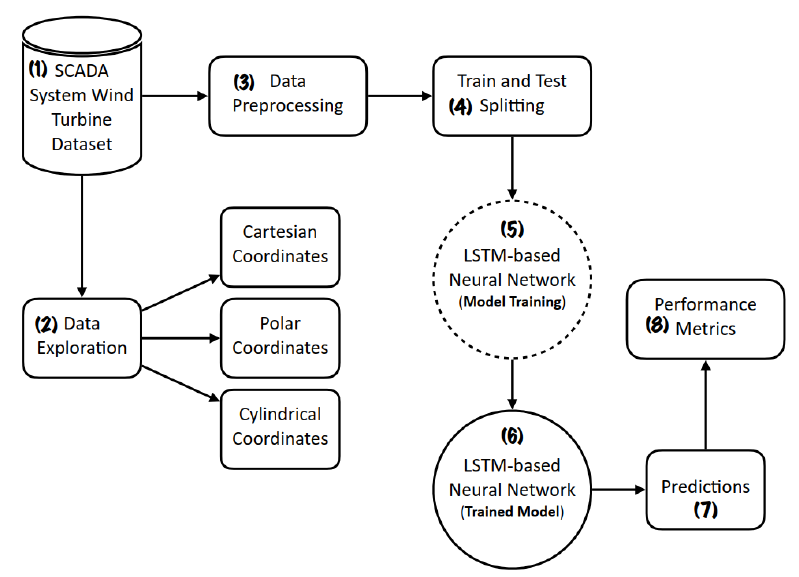
Figure 1. The proposed model of wind turbine data analysis and